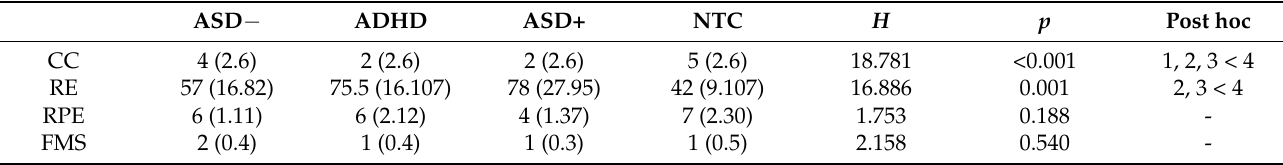
Table 4. Group differences of WCST indices.